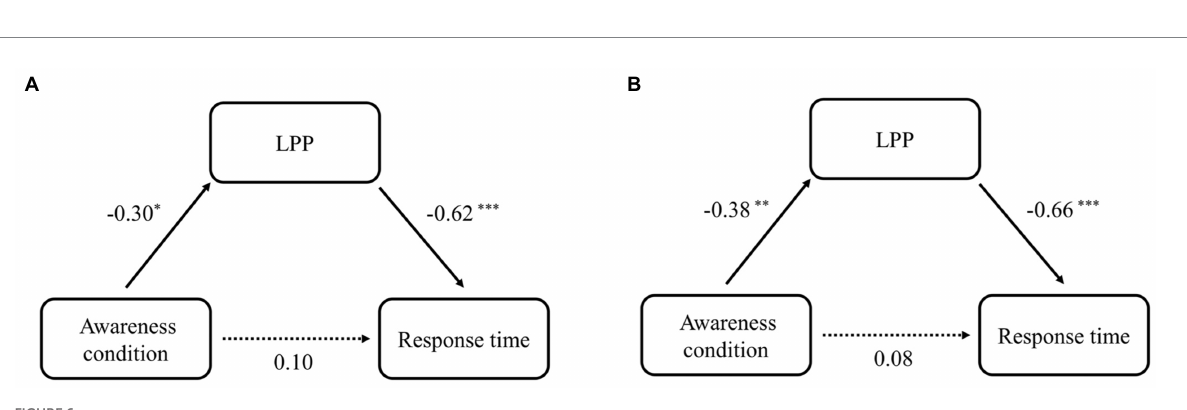
FIGURE 6 The mediating effect of LPP in the influence of awareness group (self-awareness and control) on RT at 1-back (A) and 2-back (B) . The values indicate standardization coefficients (Beta). * p < 0.05; ** p < 0.01; *** p <